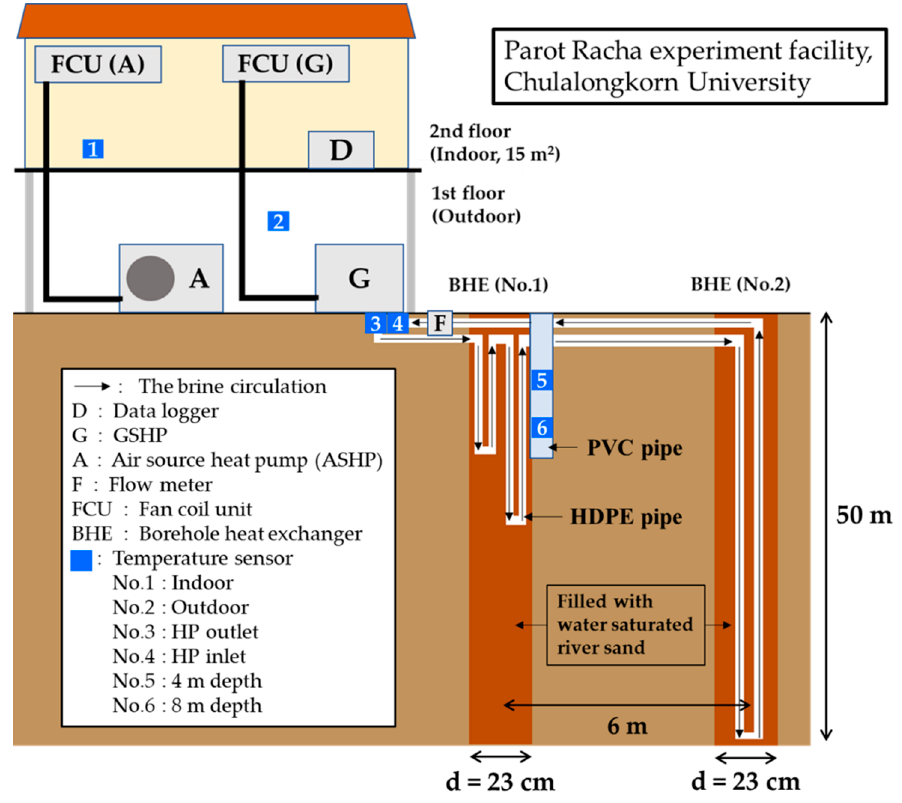
Figure 2. Schematic illustration of the experimental apparatus.